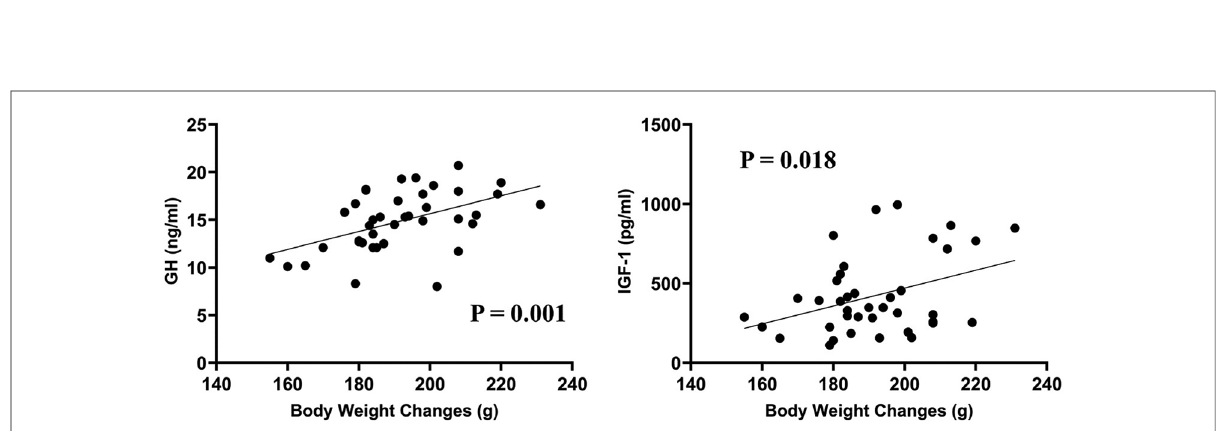
FIGURE 2 Among all the 39 rats, the body weight changes correlated signi fi cantly with both serum GH (correlation coef fi cient=0.495, P =0.001) and IGF-1 concentrations (correlation coef fi cient=0.377, P